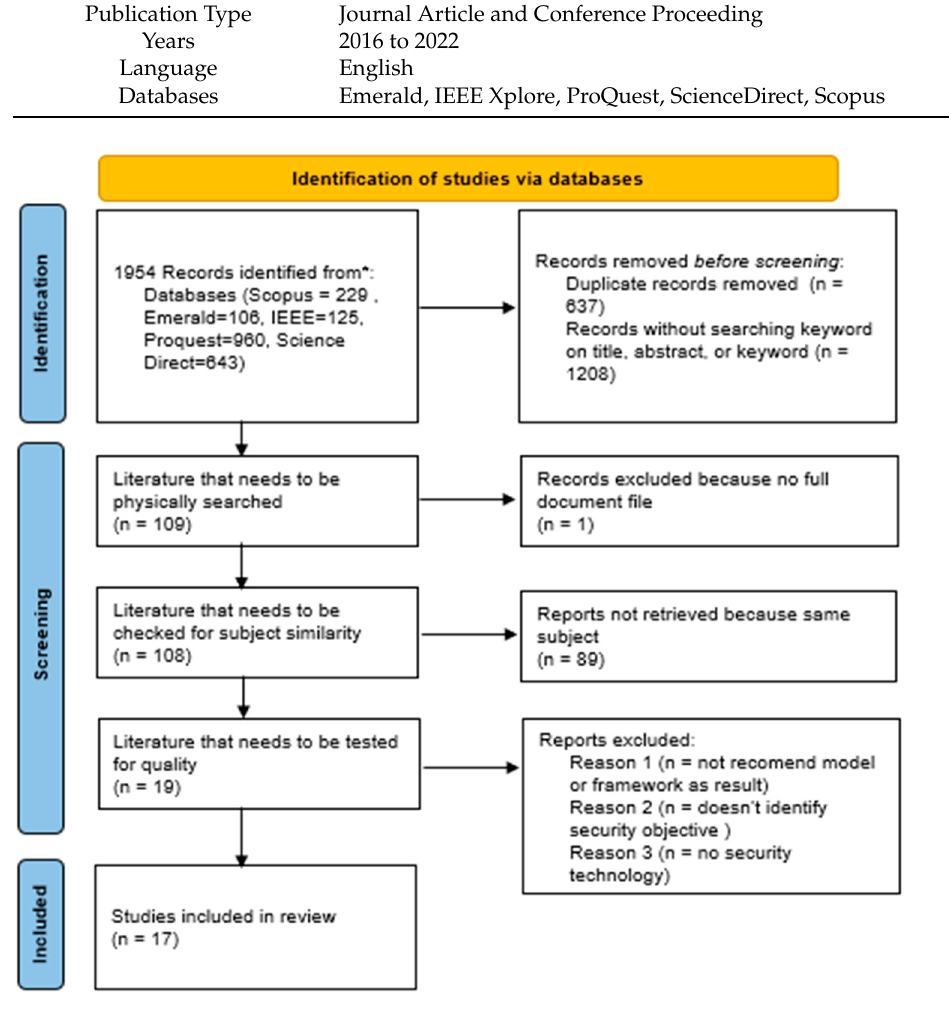
Figure 1. SLR flow